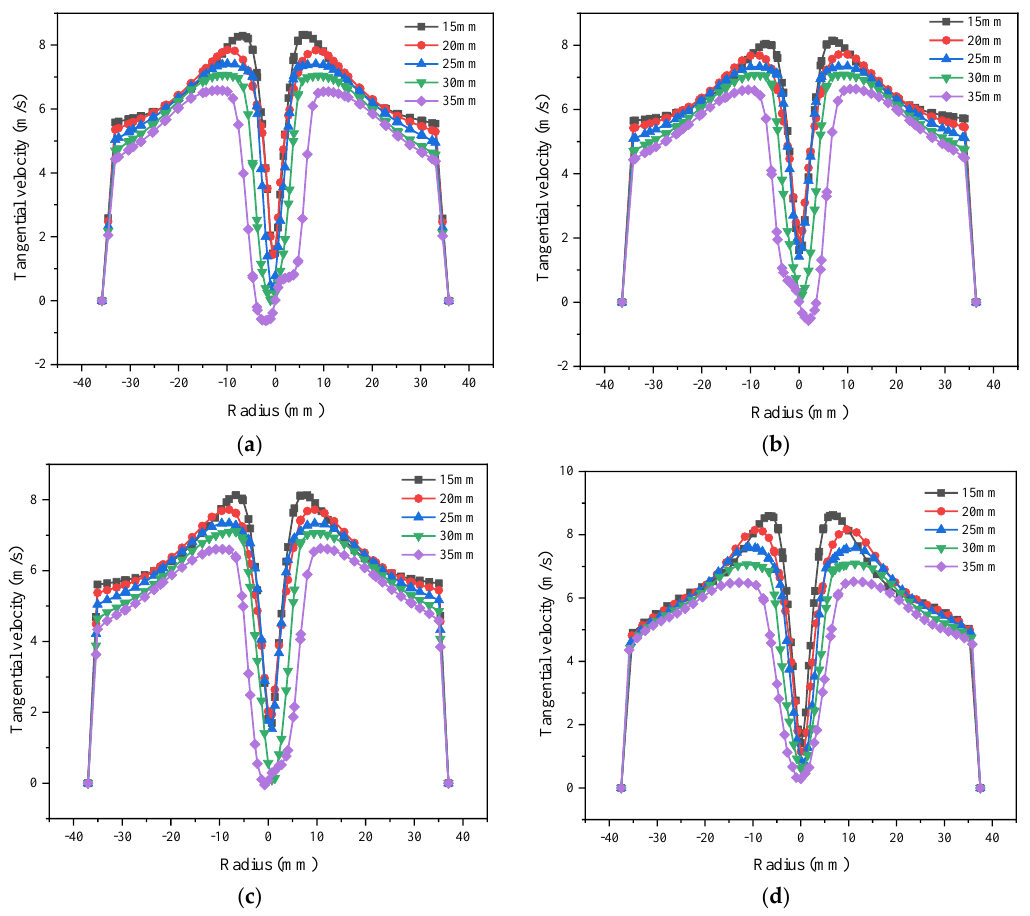
Figure 12. The tangential velocity: ( a ) Z = 75; ( b ) Z = 100; ( c ) Z = 125; ( d ) Z = 175.